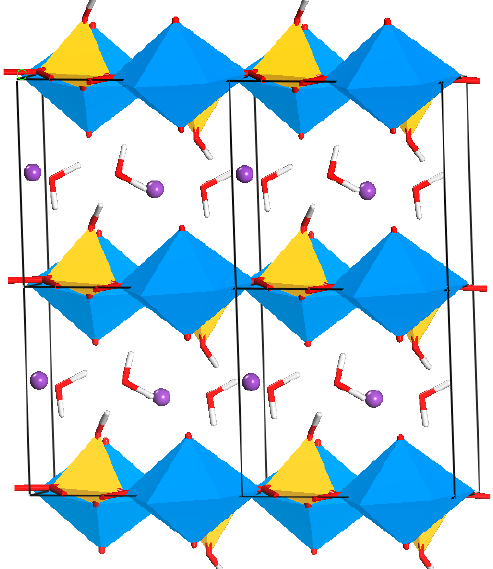
Figure 1. Atomic model showing the uranyl silicate sheets of boltwoodite K(UO )SiO OH(H O) , where the interlayer (between the sheets) is filled with K and H 2 3 2 1.5 Colors for the atoms are as follows: U 6+ blue, Si 4+ yellow, K + purple, O 2 − red, H +